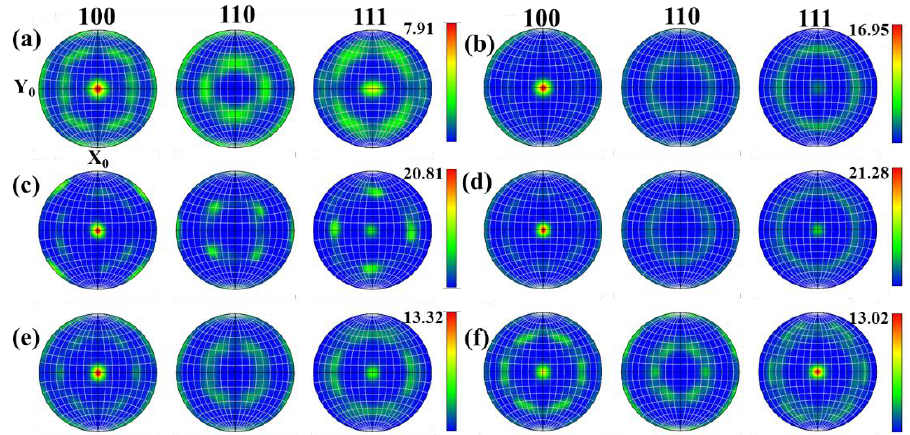
Figure 15. Pole figures of Mo − 1.5wt%ZrO 2 molybdenum alloy at a strain rate of 0.01 s −1 : ( a ) 1000 °C